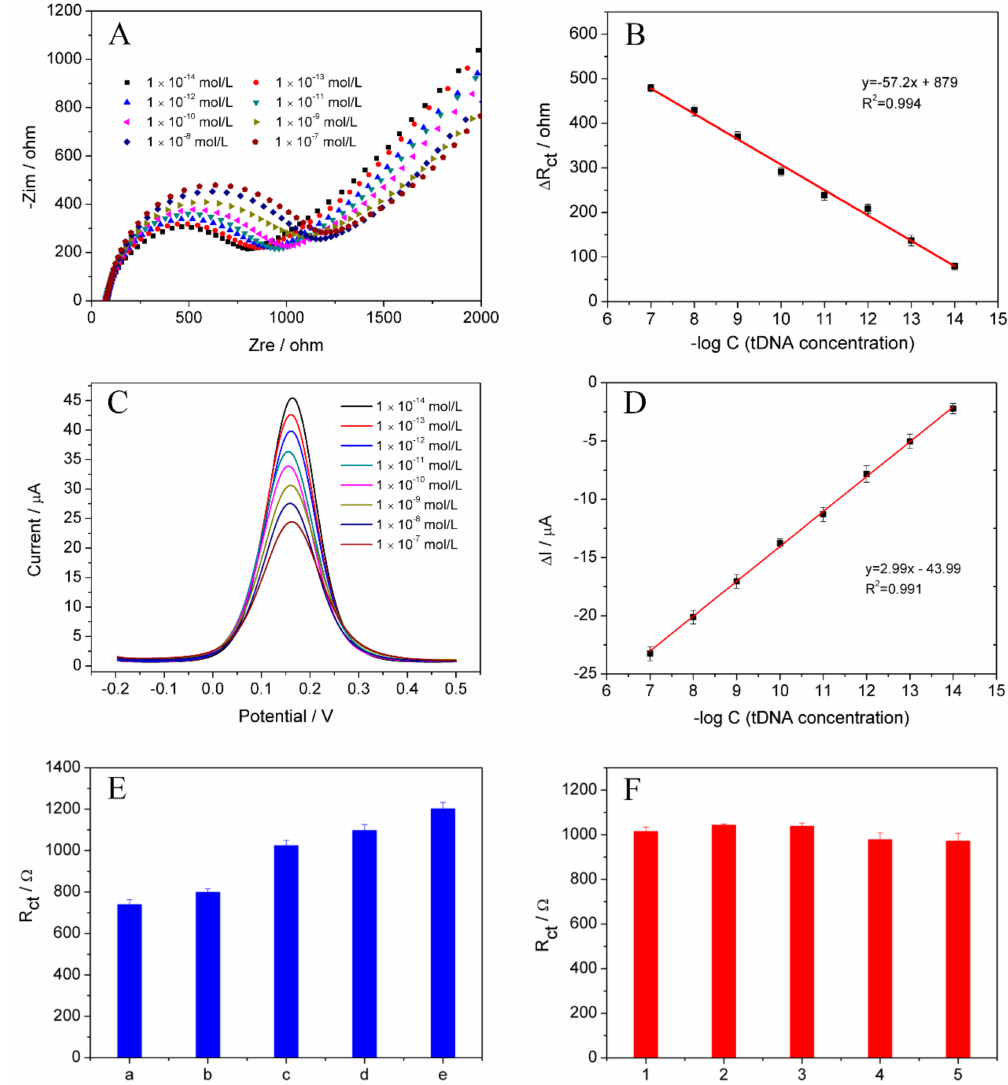
Figure 5. ( A ) Resistance values of the biosensor containing increasing concentration of C. perfringens sequence (1.0 × 10 − 7 , 1.0 × 10 − 8 , 1.0 × 10 − 9 , 1.0 × 10 − 10 , 1.0 × 10 − 11 , 1.0 × 10 − 12 , 1.0 × 10 − 13 , and 1.0 × 10 − 14 mol/L). ( B ) Plots of ∆ R vs. logarithm of tDNA concentration. ( C ) DPV responses for different concentration of tDNA from 1.0 × 10 − 7 to 1.0 × 10 − 14 mol/L. ( D ) Plots of ∆ I vs. logarithm of tDNA concentration. ( E ) Comparison of R ct values of: ssDNA (a); ssDNA hybridized with non-complementray DNA (b); three base-mismatched DNA (c); one base-mismatched DNA (d); and target DNA (e). ( F ) Differences of five separate electrode. The error bars represent the standard deviation of three